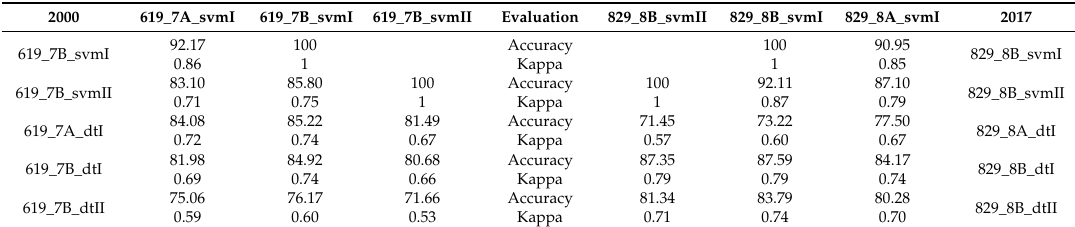
Table 5. The accuracy and kappa values of processed images against with each other at selected years (2000 and 2017) with di ff erent machine learning